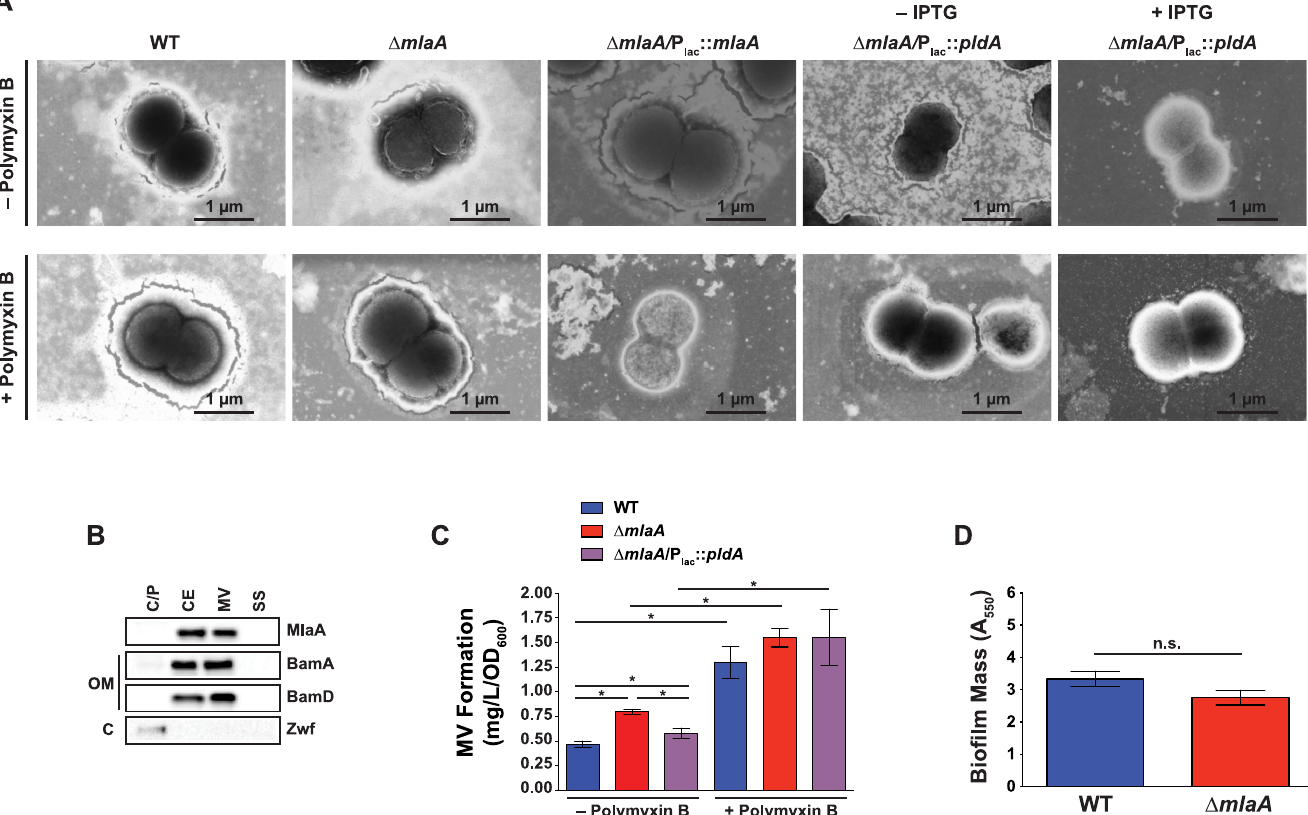
Fig 7. Investigations of MlaA effects on cell structure, membrane vesicles, and biofilm formation. (A) Strains as indicated were cultured in liquid medium without (top row) or with (bottom row) polymyxin B until approximately mid-logarithmic growth. Δ mlaA /P lac :: pldA was cultured in the presence or absence of 0.5 mM IPTG, as indicated. Bacteria were subsequently washed twice with PBS, spotted onto 300 mesh copper grids, negatively stained with phosphotungstic acid, and imaged using scanning electron microscopy. (B) Cytoplasmic/periplasmic (C/P), cell envelope (CE), membrane vesicle (MV), and soluble supernatant (SS) subcellular fractions of WT FA1090 collected under standard aerobic conditions were prepared and normalized based on protein concentration, separated by SDS-PAGE, and probed with indicated antisera. (C) MVs collected by ultracentrifugation of culture supernatants derived from strains indicated were quantified by protein concentration ( n = 6 for WT and Δ mlaA for − polymyxin B condition; n = 3 for all others; mean ± SEM). (D) WT FA1090 and Δ mlaA bacteria were suspended to an OD 550 of 1.5 in GCBL, added to 96 well microtiter plates, and cultured without shaking in 5% CO 2 at 37 ˚C for 24 h. Planktonic bacteria were removed and biofilms were washed with PBS. Biofilms were allowed to dry at room temperature, then stained in 0.1% crystal violet in 2% ethanol. After staining, wells were washed with PBS and dried. Biofilms were dissolved in 30% acetic acid and quantified by A 550 measurement. Biofilm experiments were performed 12 times, each with 3 or 4 technical replicates, for a total of 46 datapoints. Mean ± SEM is presented. IPTG, isopropyl β -D-thiogalactopyranoside; C/P, cytoplasmic/periplasmic; C, cytoplasm; CE, cell envelope; OM, outer membrane; MV, membrane vesicle; SS soluble supernatant; SDS-PAGE, sodium dodecyl sulfate-polyacrylamide gel electrophoresis; OD 550 , optical density at 550 nm; A 550 , absorbance at 550 nm, GCBL, gonococcal base liquid